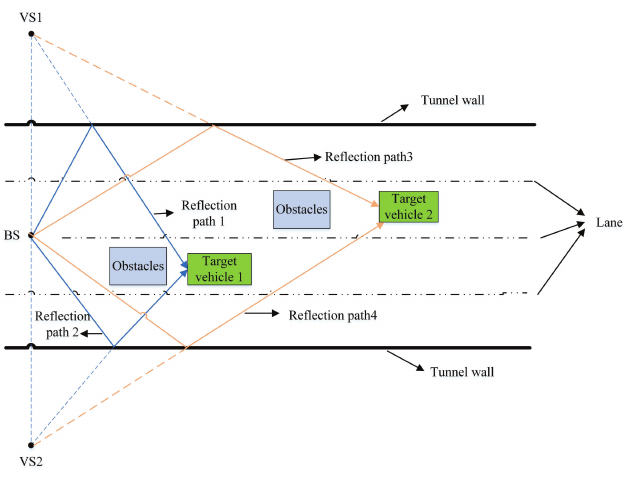
Figure 2. Vehicle localization based on reflecting paths from tunnel